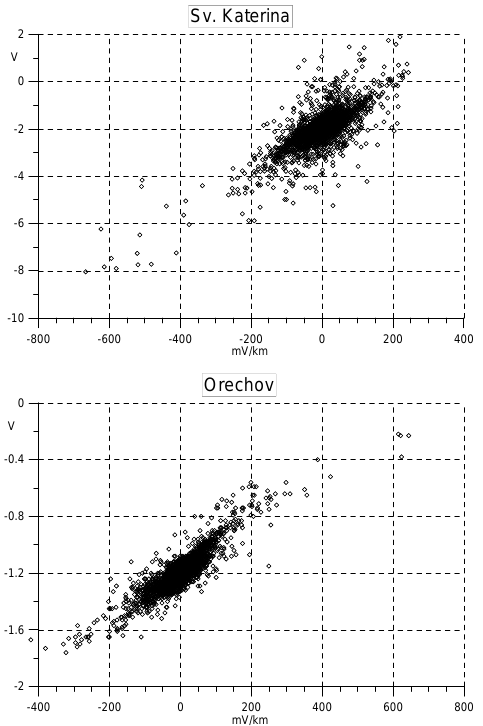
Fig. 7. Scatter graphs of the P/S voltage [mV/km] vs. computed geoelectric field [V] for the whole period from 24 October to 1 November 2003.